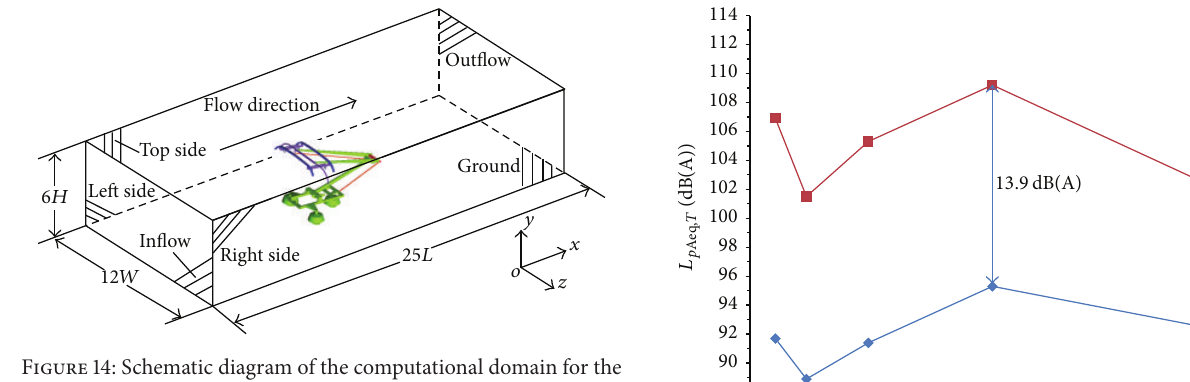
Figure 14: Schematic diagram of the computational domain for the pantograph model.